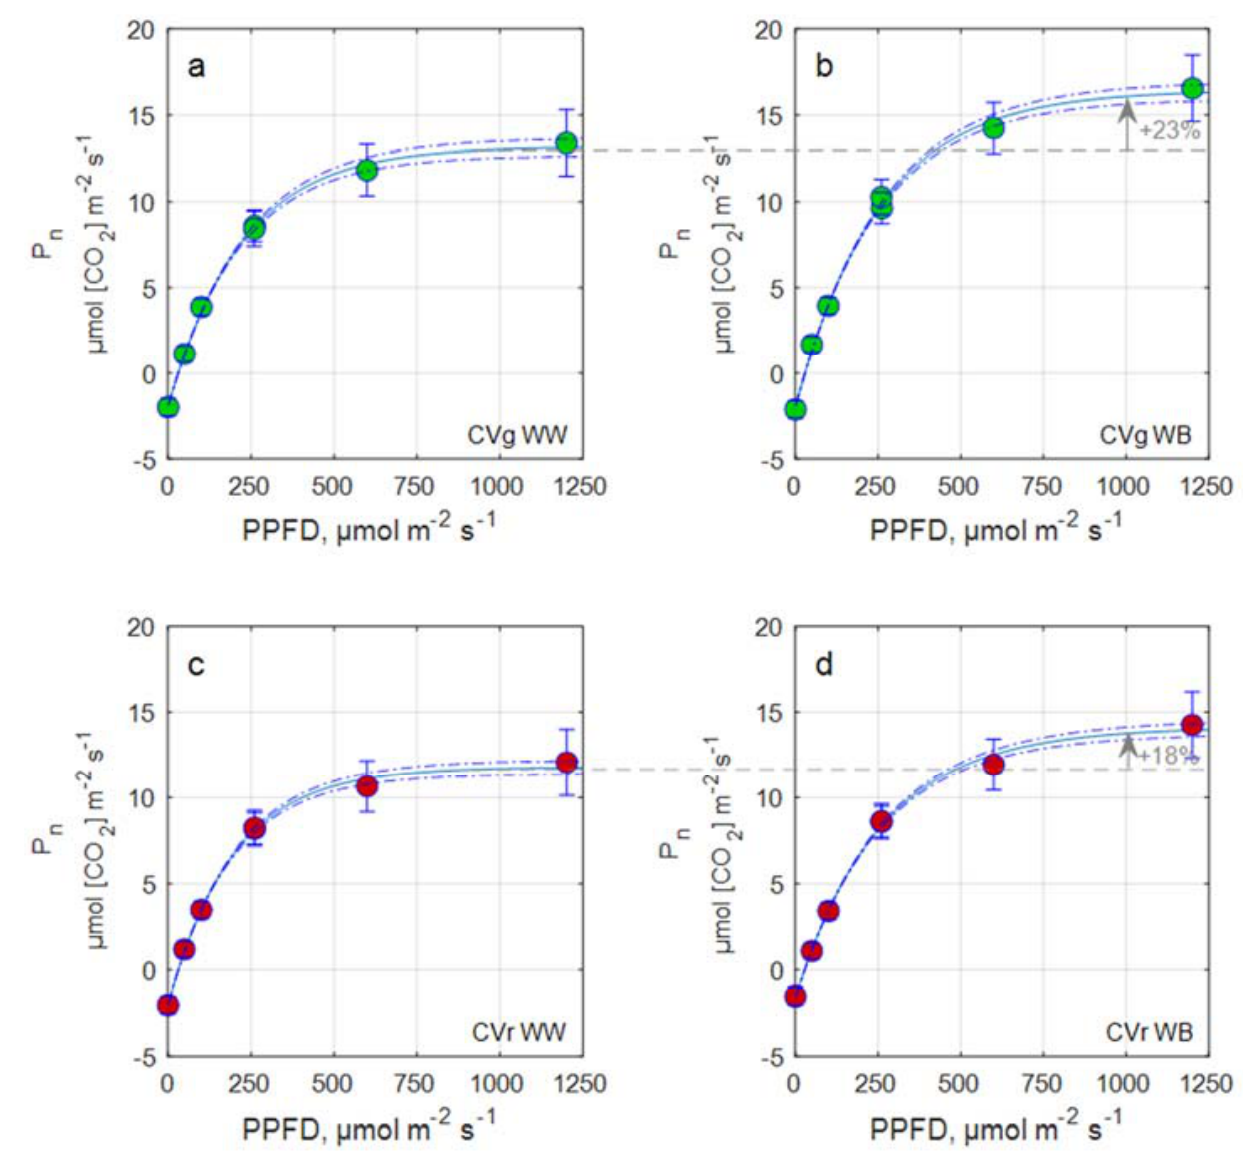
Figure 3. Exponential light response curve with maximum net photosynthesis and chemical light use efficiency (LUE) fitted to measured net photosynthesis rate, P n for Aquino (CVg) ( a , b ) and Barlach (CVr) ( c , d ) treated with white light (WW) or white-blue light (WB) spectra for 15 days.